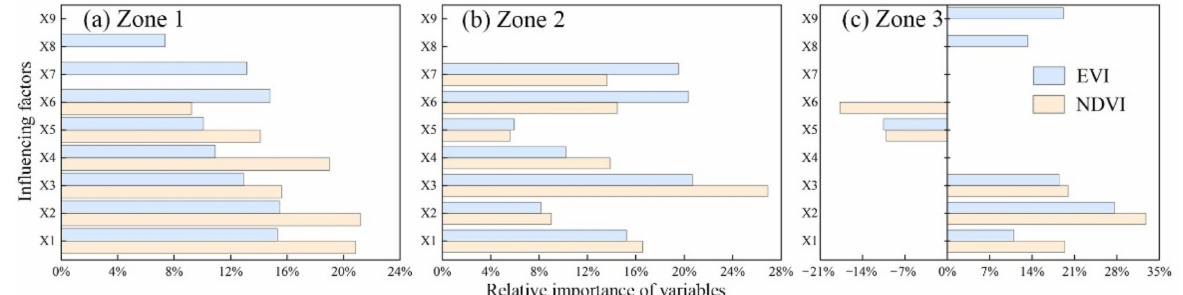
Figure 10. Bar charts of the significance of the driving factors. ( a – c ) are the three study areas, and only the important variables are shown on the bar chart because the significant driving factors are different in each area. Blue represents EVI as the dependent variable, and orange represents NDVI as the dependent